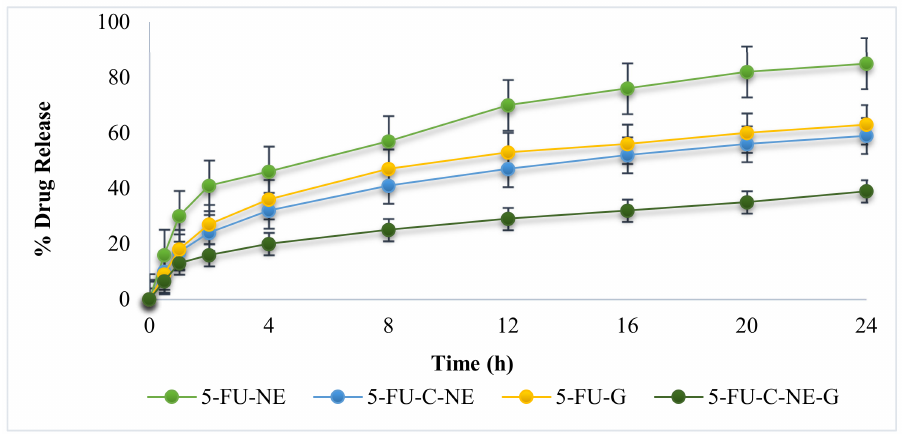
Figure 3. Profile of in vitro drug